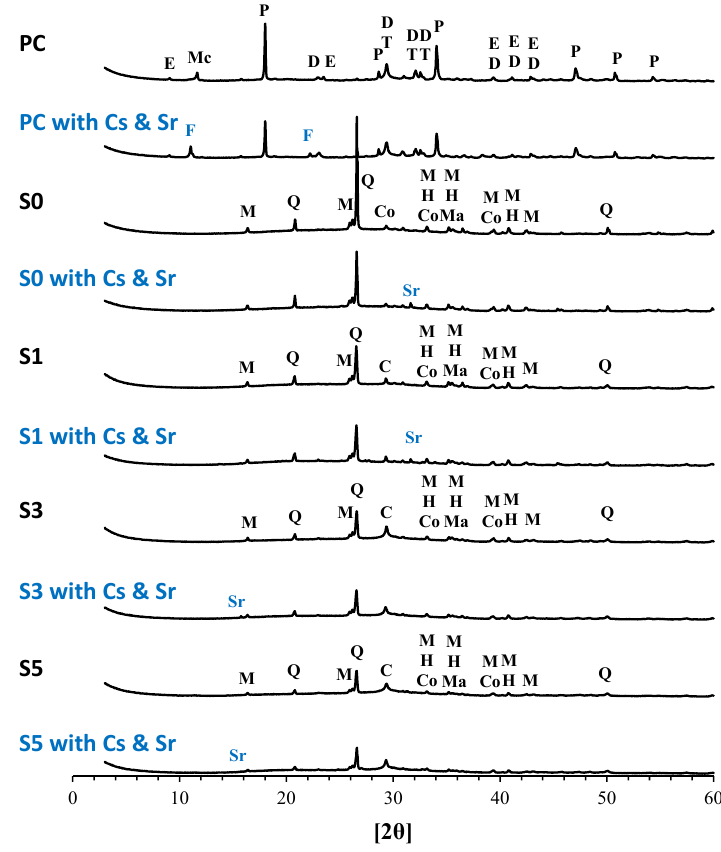
Figure 2. The influence of the incorporated cesium and strontium on the crystalline structures of the binder.